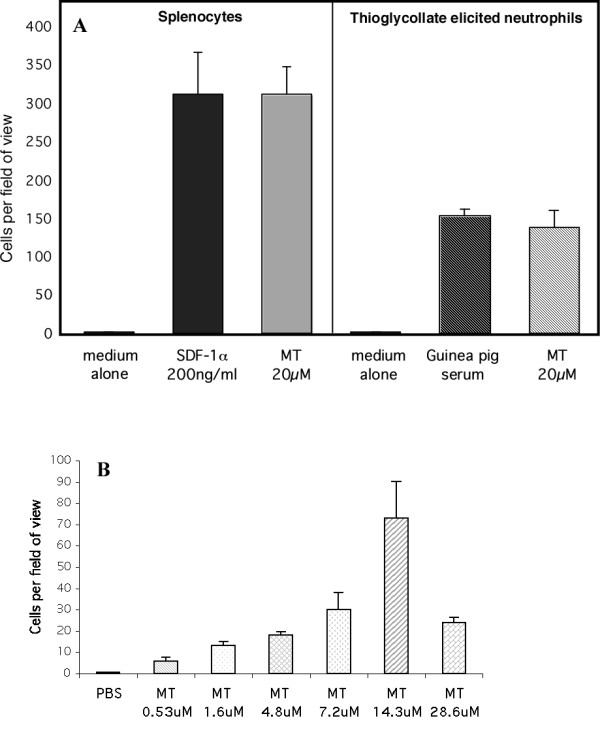
Chemotactic responses of cells to metallothionein in the modified Boyden chamber assay. A. Mouse splenocytes or Thioglycollate-elicited cells respond to guinea pig serum (as a source of activated complement) and to metallothionein. Cells that had migrated to the lower side of the filters were counted in at least six fields of view per well. Data are means of six fields in each of six replicates. The data shown is representative of three experiments and is expressed as the average ± standard deviation. B. Dose response curve of chemotaxis to metallothionein. Different concentrations of metallothionein were loaded into the lower wells of the Boyden chambers and Jurkat T cells were added to the upper wells.